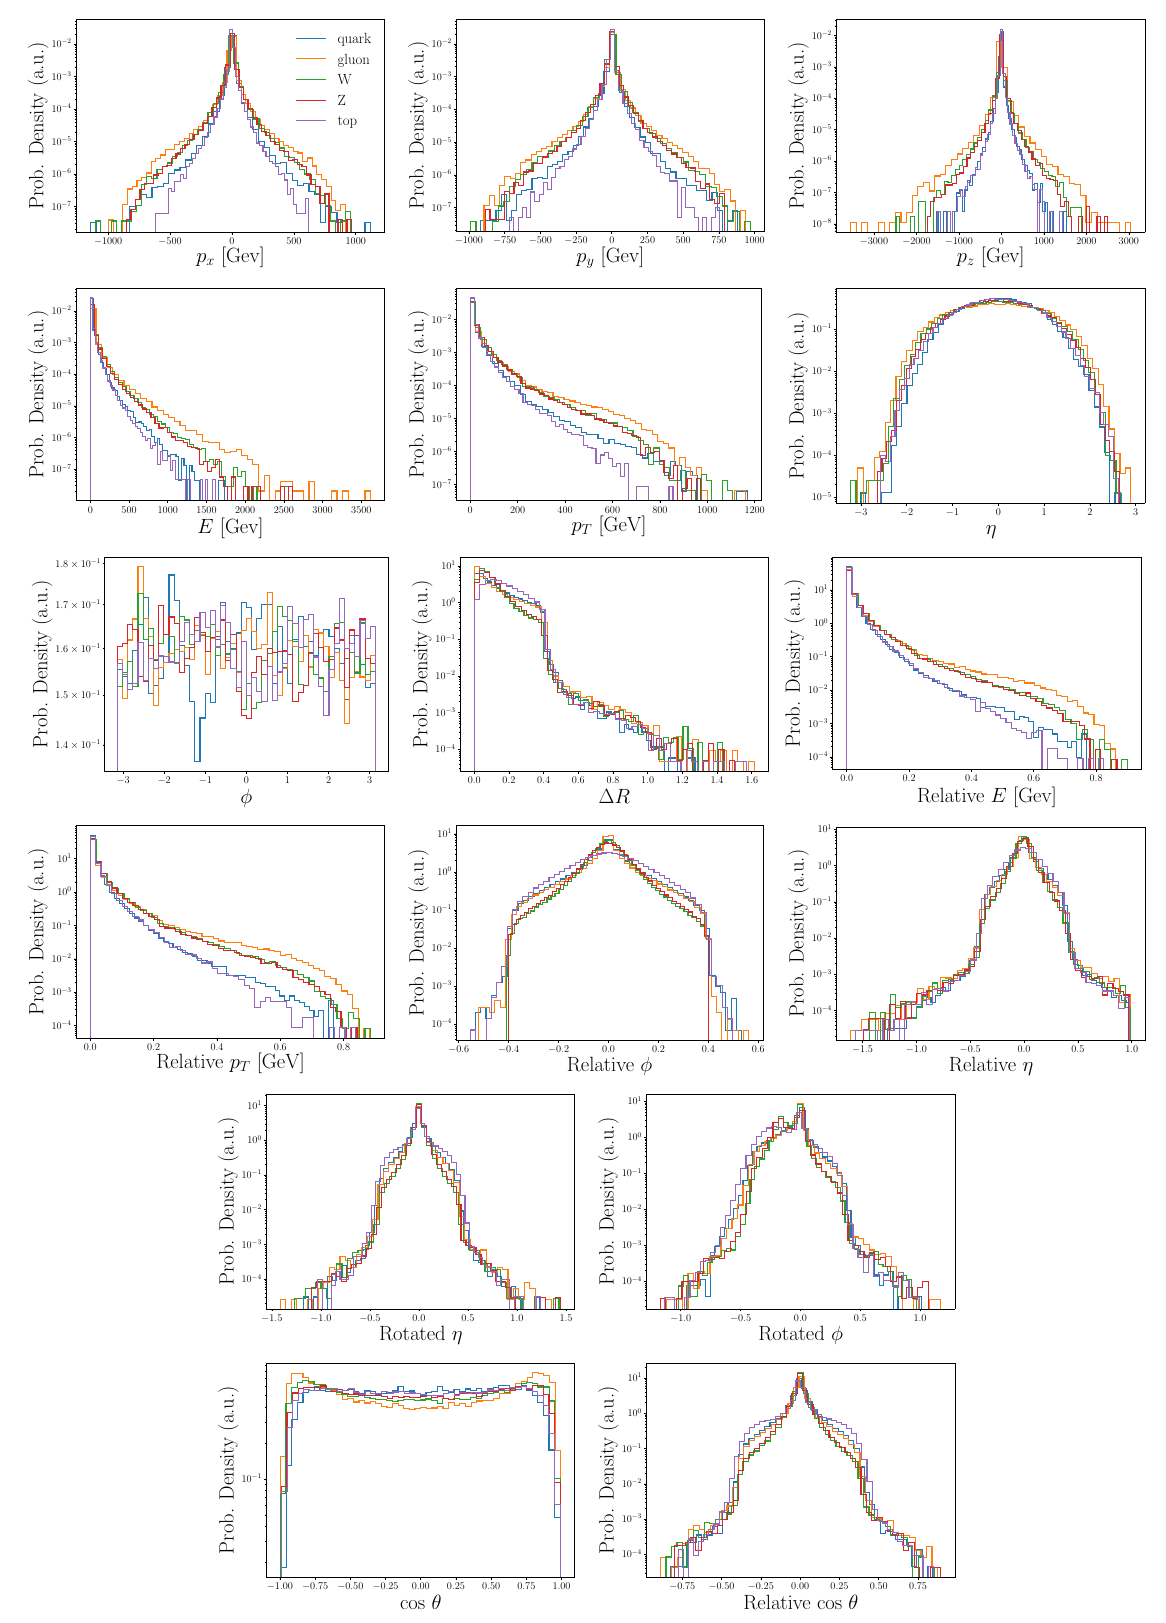
Fig. 5 Distributions of kinematic features described in the text for the 150 highest- p T particles in each